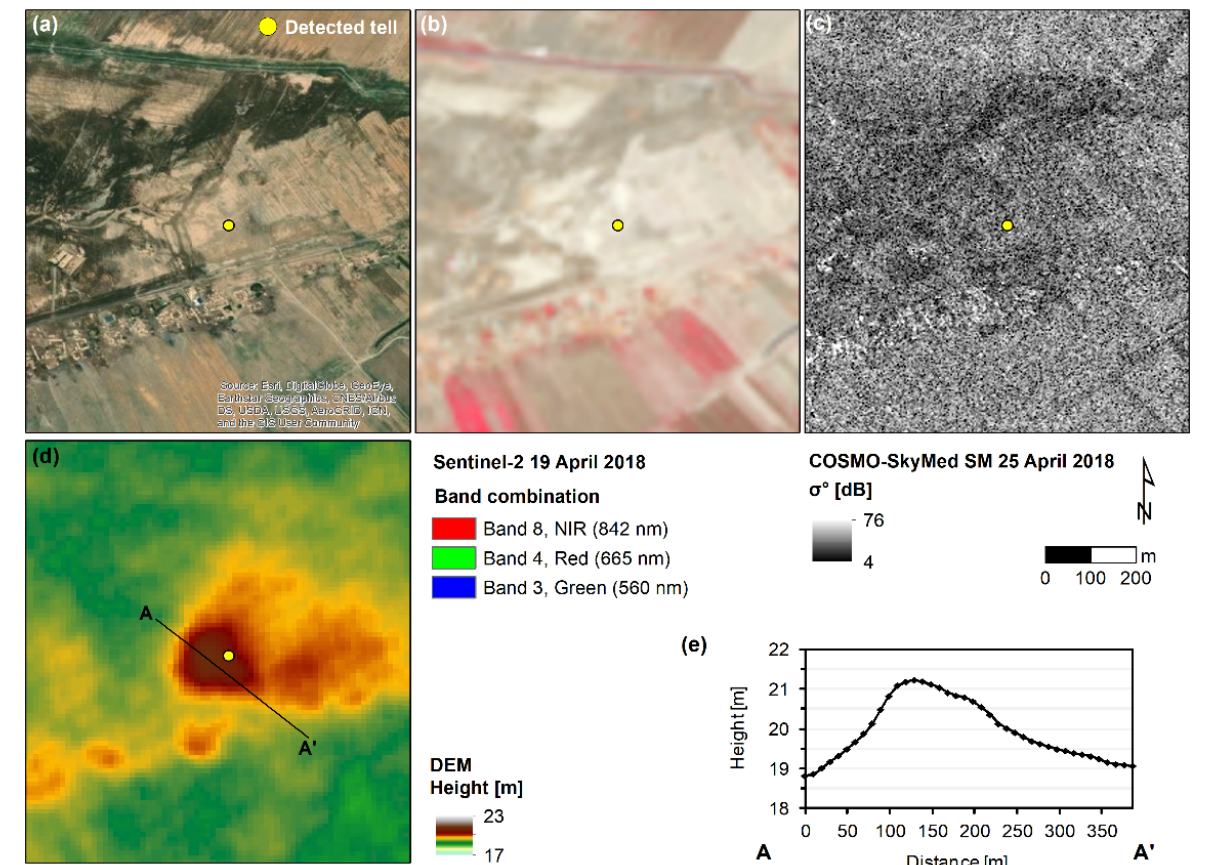
Figure 7. Tell detection through combination of ( a ) VHR optical imagery, ( b ) Sentinel-2 multispectral false-colored composite (R: Band 8—NIR; G: Band 4—red; B: Band 3—green), COSMO-SkyMed ( c ) SAR radar backscatter image, and ( d ) DEM with ( e ) height profile drawn along A-A’ section. Products in ( b – d ) were all collected in April 2018, as per Figure 6. Example of small flat mound (Neo-Babylonian to Islamic periods; precise location undisclosed for security concerns) that is detected thanks to the DEM only. COSMO-SkyMed ® Products ©ASI, Italian Space Agency, 2018. All rights reserved. Contains Copernicus Sentinel-2 data, 2018.